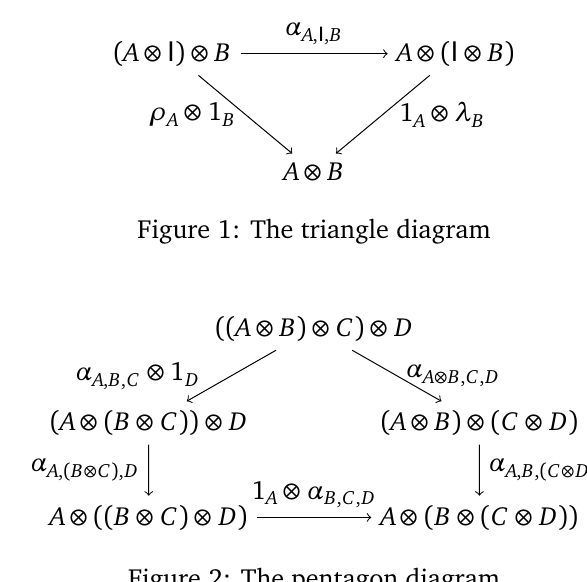
Figure 2: The pentagon